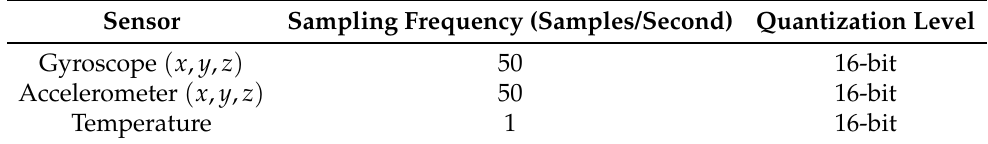
Table 4. Sensors configuration (sampling and